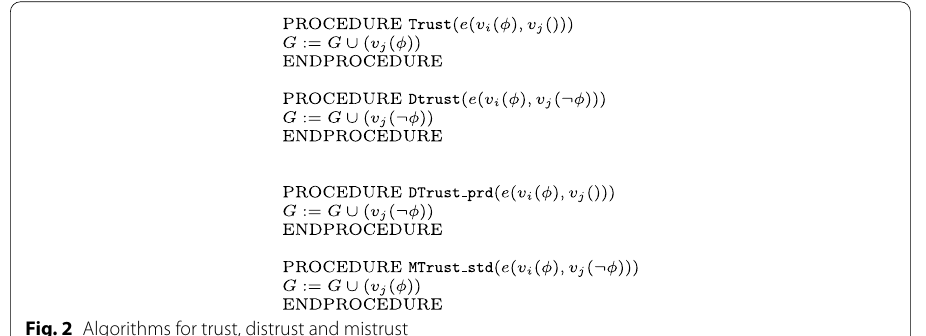
Fig. 2 Algorithms for trust, distrust and